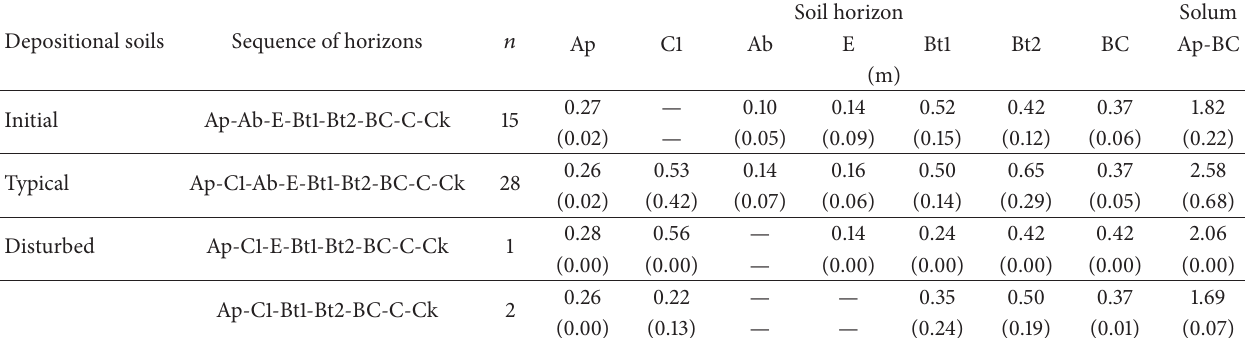
Table 2: Number and mean depth (m) of horizons of depositional soils (standard deviation in brackets). Depositional soils